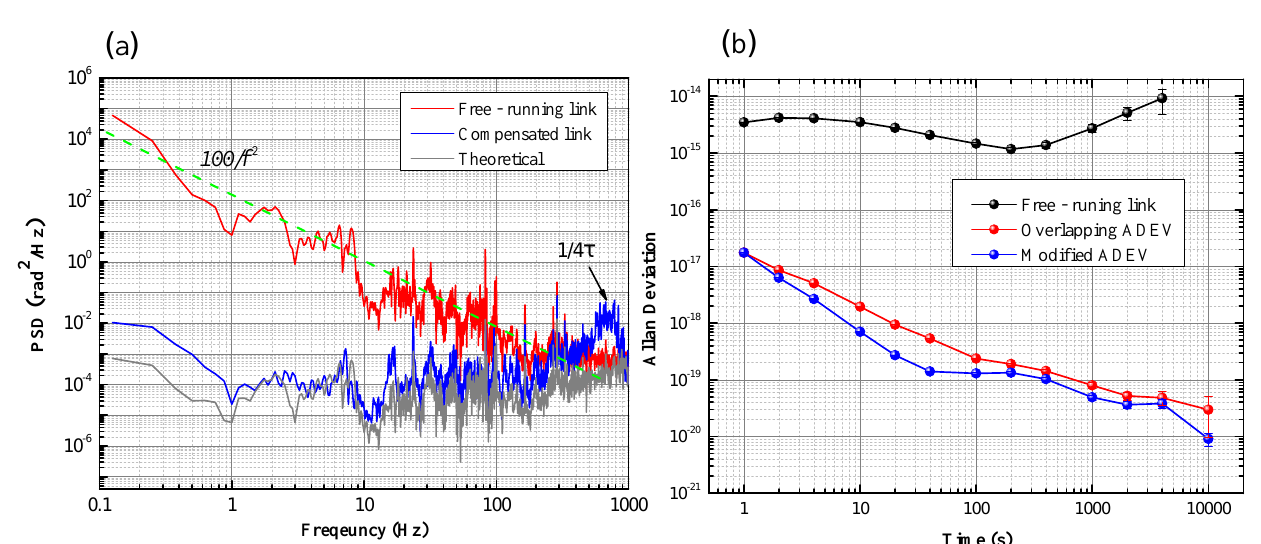
Figure 3. ( a ) The phase noise of the optical frequency transfer, where the red curve is the phase noise of the free-running link; the blue curve is the phase noise of the locked and compensated link; and the gray curve is the phase noise of the theoretical value. ( b ) The Allan deviation of the optical frequency transfer, where the black dot curve is the free-running link; the red dot curve is the overlapping ADEV of the compensated link; and the blue dot curve is the modified ADEV of the compensated